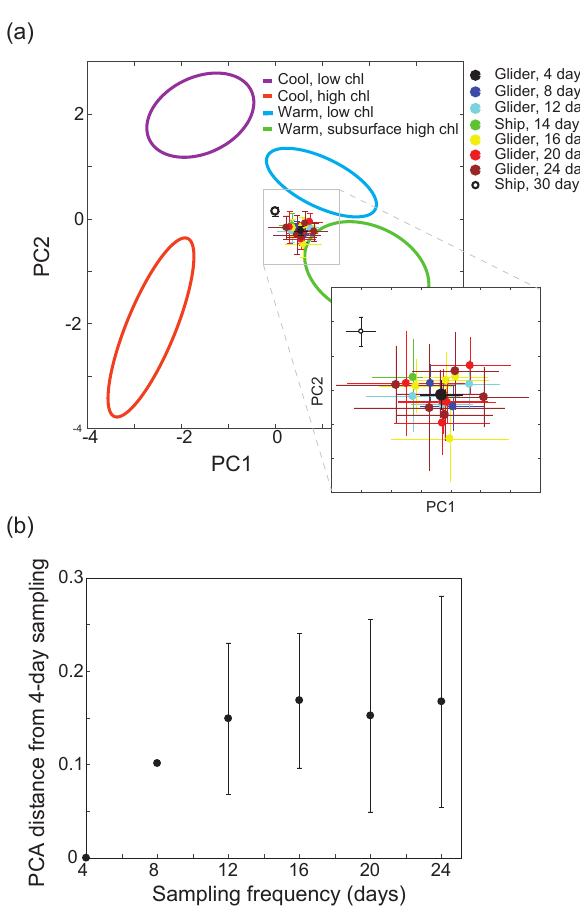
Figure 8. Impact of sampling frequency. Panel (a) shows the impact of different sampling frequencies on the estimated SPOT water col- umn profile characteristics. The mean and standard deviation of the full glider dataset for SPOT ( ∼ 4-day sampling, one dataset) from March to July 2013 and 2014 are shown in black. The mean and standard deviation of the subsampled glider dataset for the SPOT site (8 days, two datasets; 12 days, three datasets; 16 days, four datasets; 20 days, five datasets; 24 days, five datasets) are shown as colored circles. For reference, the mean and standard deviation of the ship-based SPOT time series samples from March to July (Ship, 30) and the ship-based Up.R.I.S.E.E. cruise samples from March to July (Ship, 14) are shown. The 95% confidence intervals for the four end-member profiles are also shown. Panel (b) displays the differences in estimated characteristics for the subsampled datasets relative to the full glider dataset (4-day sampling).